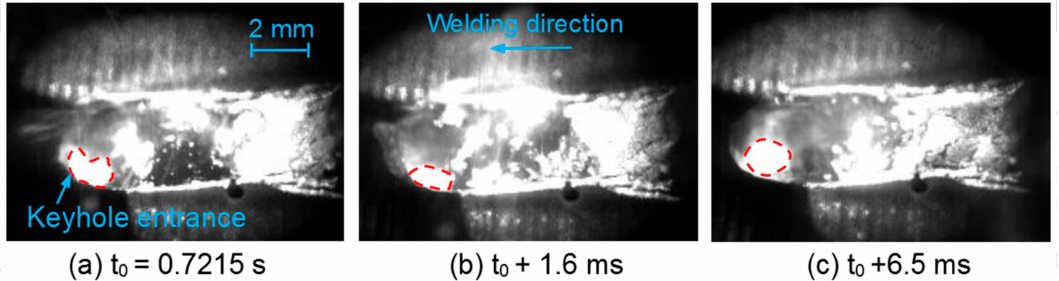
Figure 5. Images of the keyhole entrance and surface weld pool dynamics with a front gas jet